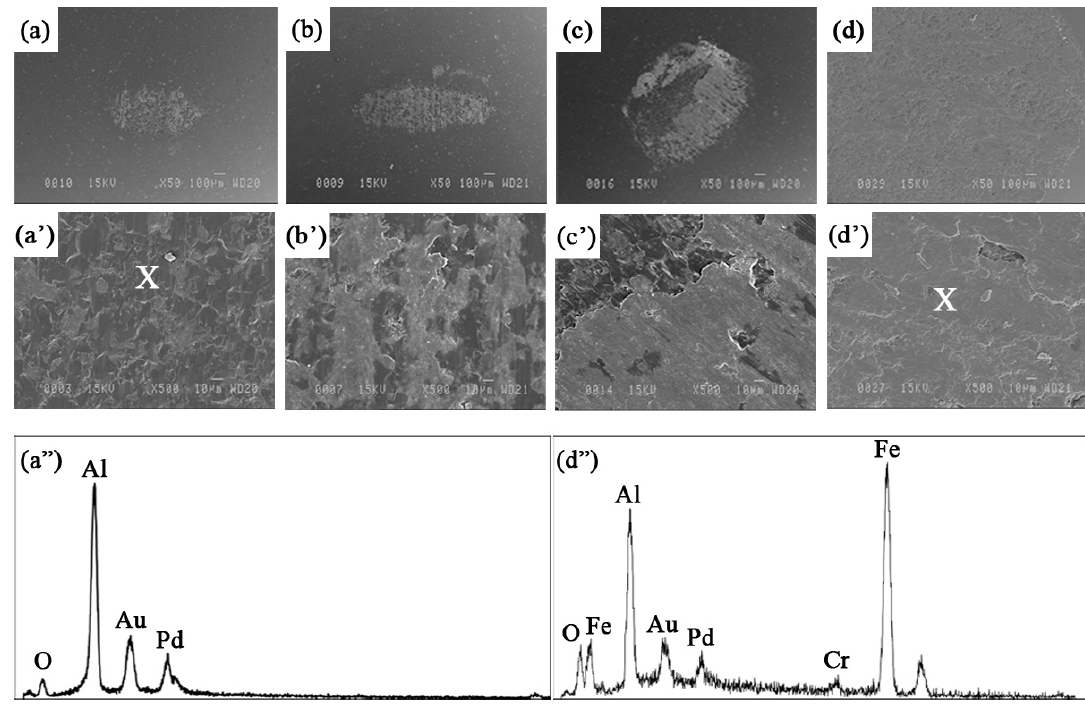
Figure 12. SEM images at different magnifications of the alumina counterpart used against Fe 3 Al at a sliding speed of ( a and a’ ) 0.04, ( b and b’ ) 0.1, ( c and c’ ) 0.3 and ( d and d’ ) 0.8 m s − 1 ; ( a” ) EDS